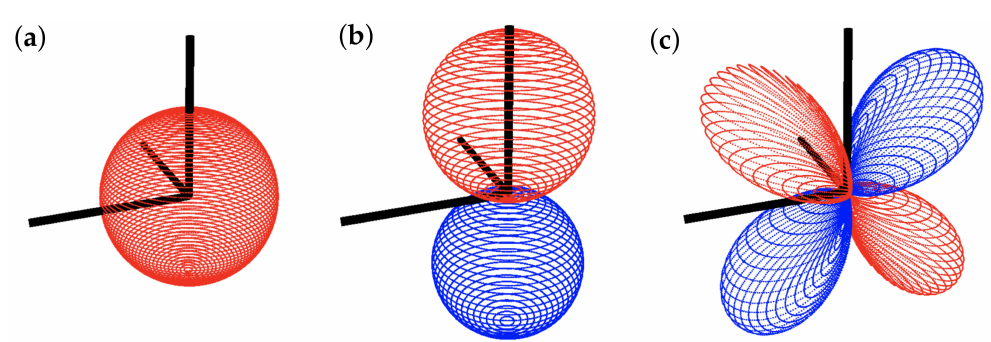
Figure 4. Examples of spherical harmonic shapes, where red points have positive magnitude and blue points have negative magnitude. ( a ) Y 0